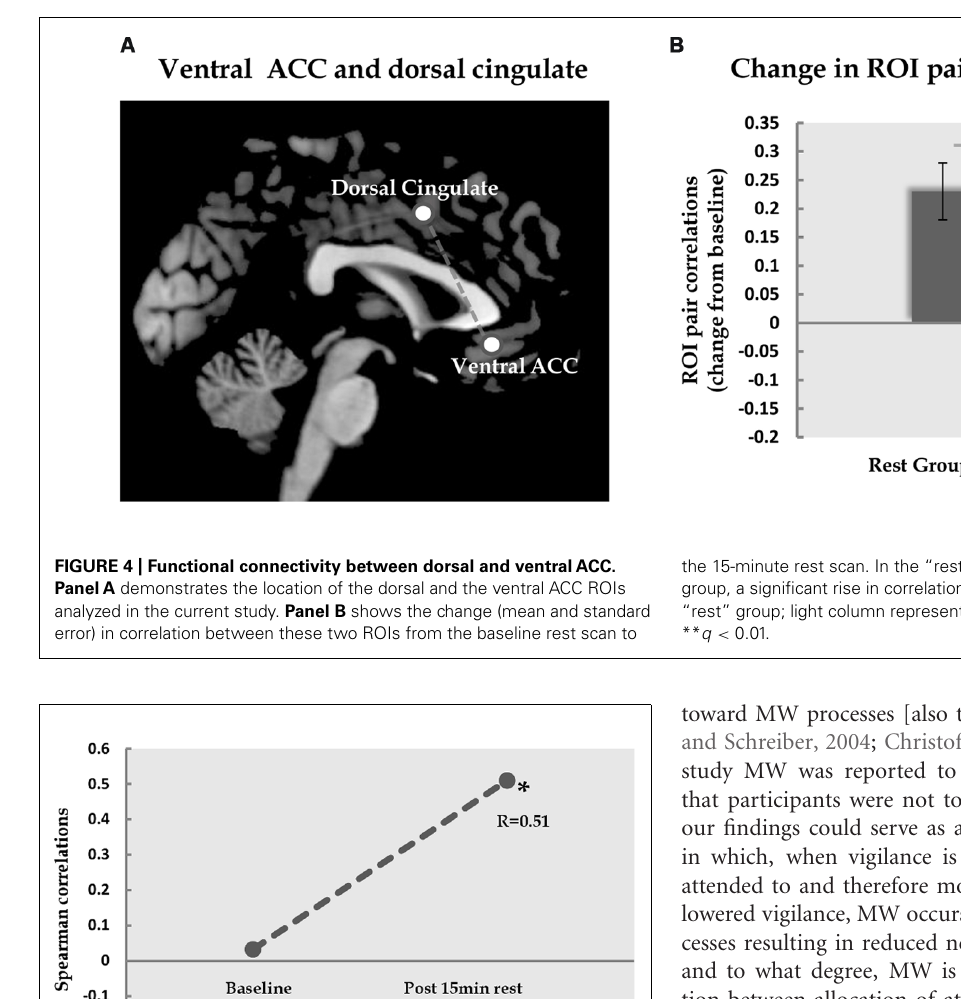
FIGURE 5 | Relation between the degree of correlation within dorsal and ventralACC, and reported negative affect. Y -axis represents Spearman correlation.Whereas the correlation between ventral ACC and dorsal cingulate was not found to be associated with negative affect at baseline, these two factors show significant correlation among the “rest” group, but not among the “drowsiness” group, following the 15-minute rest session. * p <